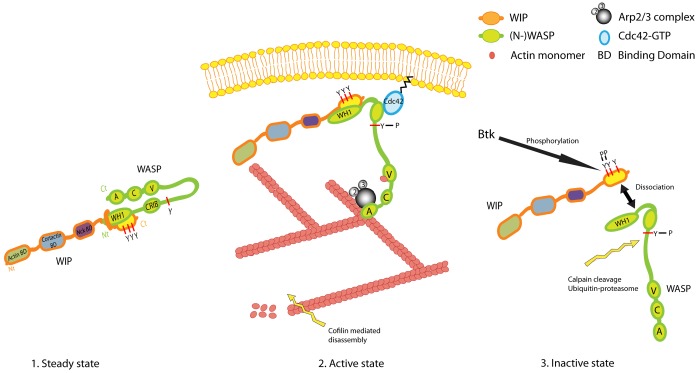
A pathway to WASP regulation. A model of the sequence through which WASP is rapidly activated and then inactivated in zones of podosome core assembly. WASP is initially held in an autoinhibited hairpin conformation while tightly linked to WIP. Following WASP activation through the binding of Cdc42 and other agents (Thrasher, 2002), Arp2/3 is bound to the freed C-terminal VCA domain where it facilitates actin filament assembly to initiate podosome core formation (Calle et al., 2008). Tyrosine phosphorylation of WIP within the WBD is sufficient to break the physical association of WIP and WASP, leaving WASP vulnerable to degradation through calpain (Chou et al., 2006; Macpherson et al., 2012) and/or ubiquitin pathways (Blundell et al., 2009; Reicher et al., 2012). The resulting dendritic filament array would then be vulnerable to dissolution through the action of cofilin or could be stabilised by replacement of WASP with cortactin.